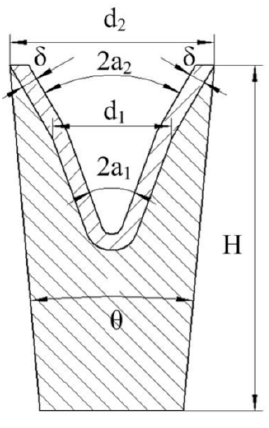
Figure 2. Schematic of the BLSC.